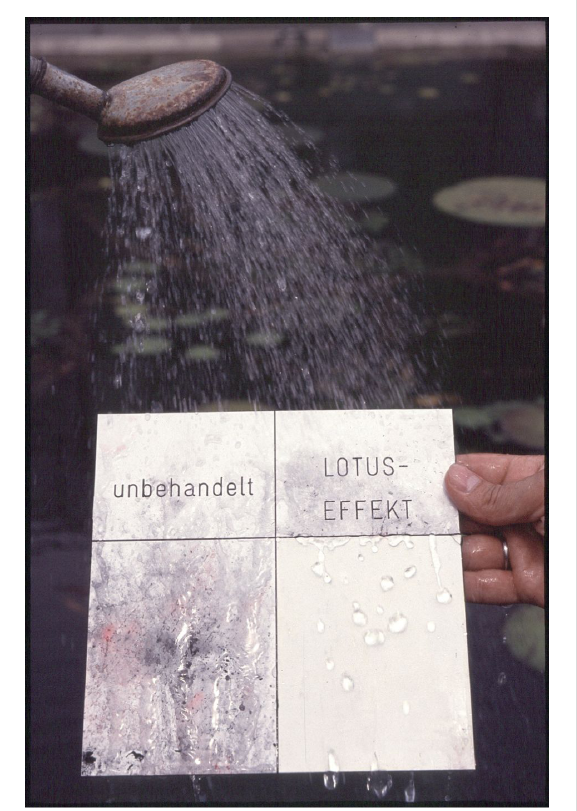
because of inappropriate technical skills and machinery. The